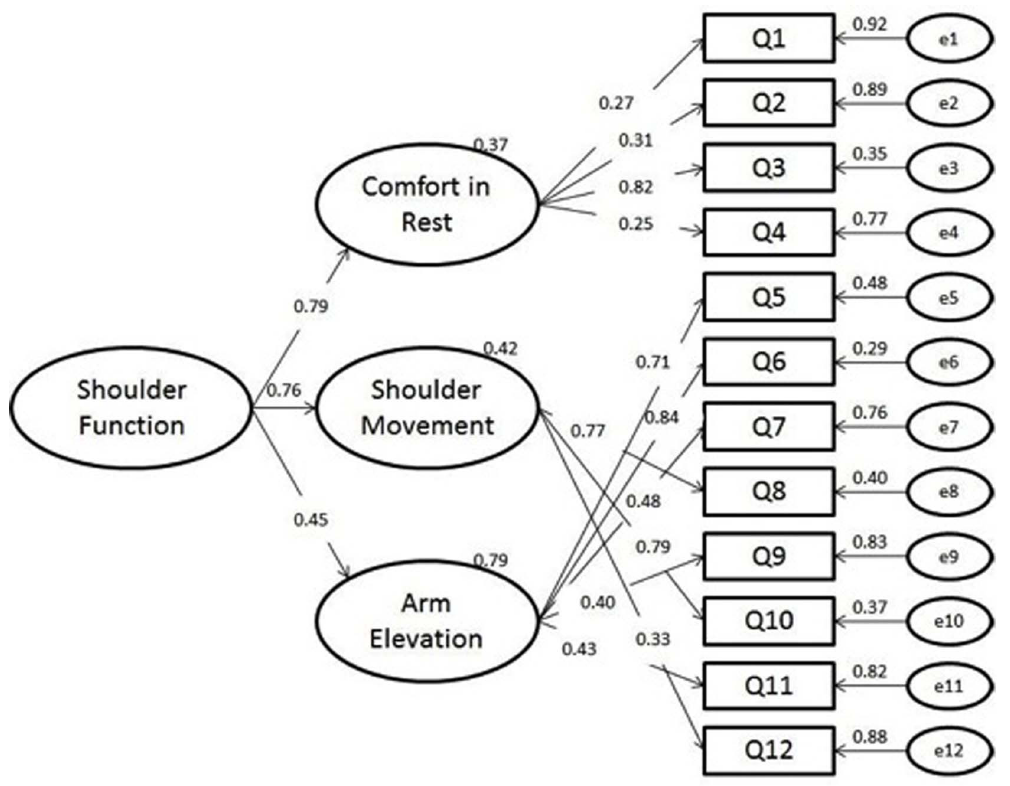
Figure 1. Confirmatory Factor Analysis.